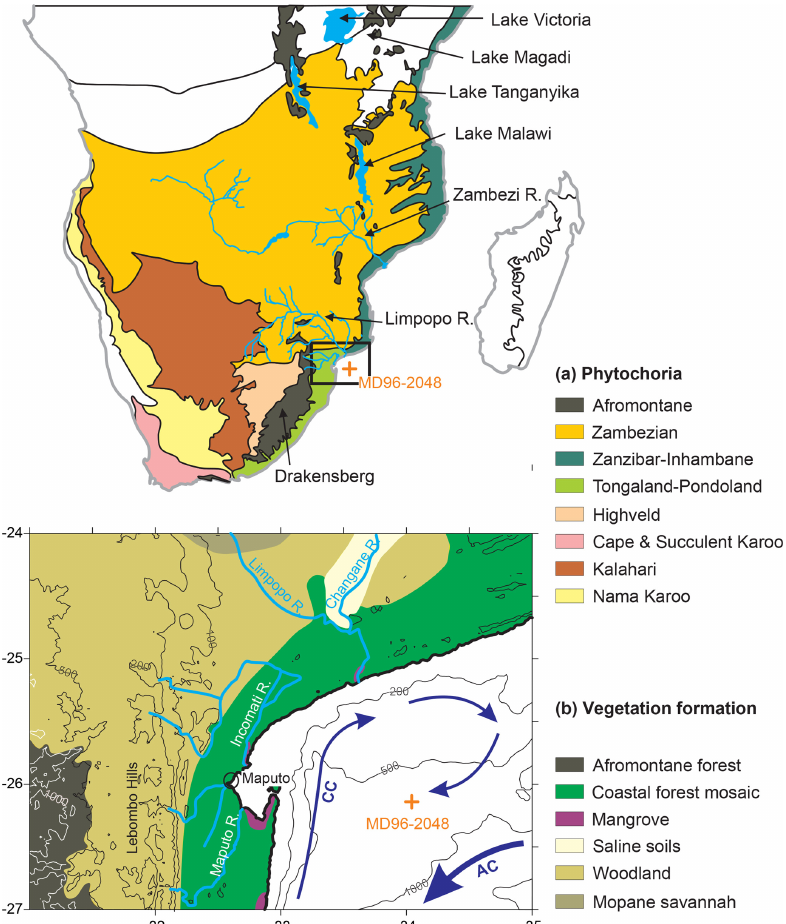
Figure 1. (a) Map of southern Africa with the main phytochoria after White (1983). (b) Site location of MD96-2048; main vegetation forma- tions; main rivers; 100, 200, 500 and 1000m contours; 200, 500 and 1000m bathymetric contours; Agulhas (AC) and counter current (CC) forming a coastal Delagoa Bight lee eddy. Zambezian vegetation woodland and savannah north of ∼ 25 ◦ 30 (cid:48) S, Tongaland–Pondoland coastal forests south of ∼ 25 ◦ 30 (cid:48) S, Zanzibar–Inhambane coastal forests east of 33–34 ◦ E. West of the escarpment with Afromontane forest rises the interior plateau covered with Highveld